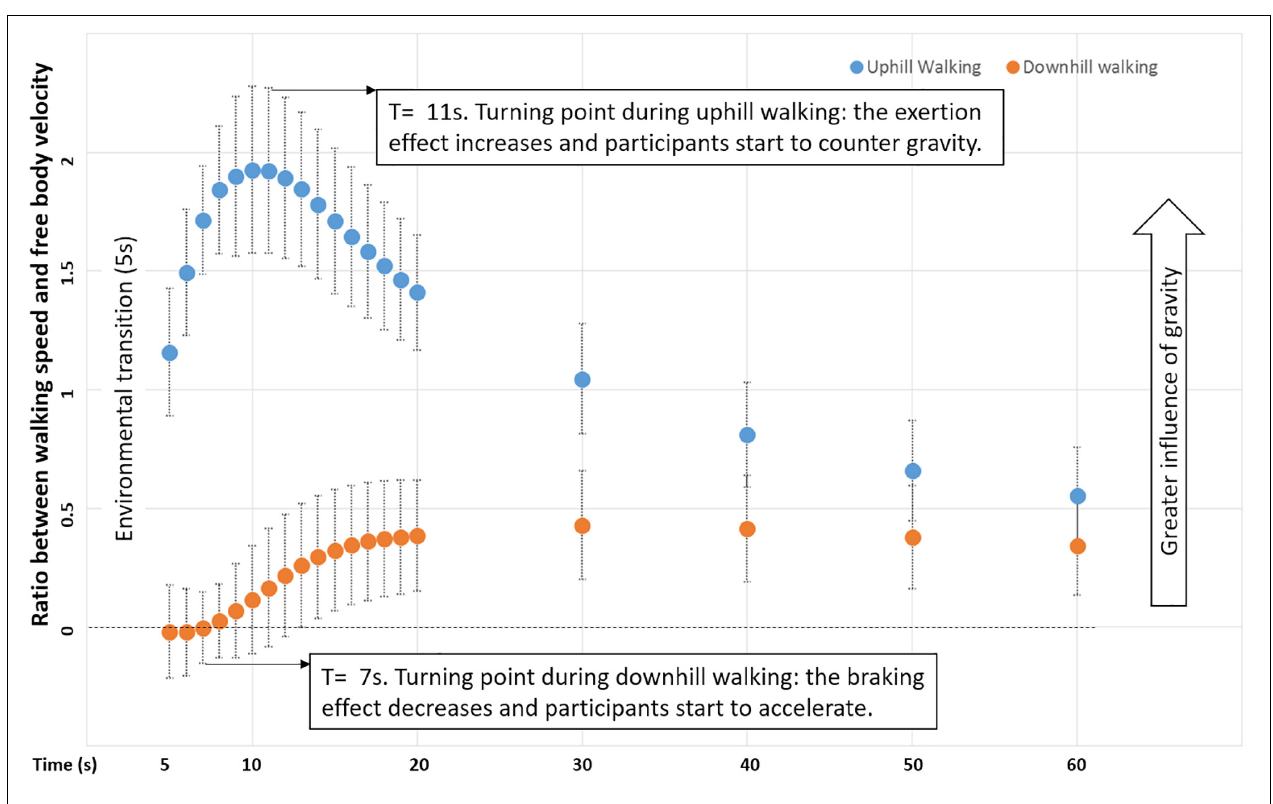
FIGURE 4 | Ratio of gravity-induced behavior in uphill and downhill walking. The ratio between walking speed and velocity of a free-moving body over time for downhill and uphill congruent conditions (mean across participants; error bars represent standard error) ( Supplementary Figure S2 and Section Materials and Methods). The turning (i.e., time) points at which participants start to reduce the braking effect and begin succumbing to gravitational acceleration in downhill walking (7 s) and, conversely, apply the exertion effect to counter gravitational deceleration in uphill walking (11 s) are